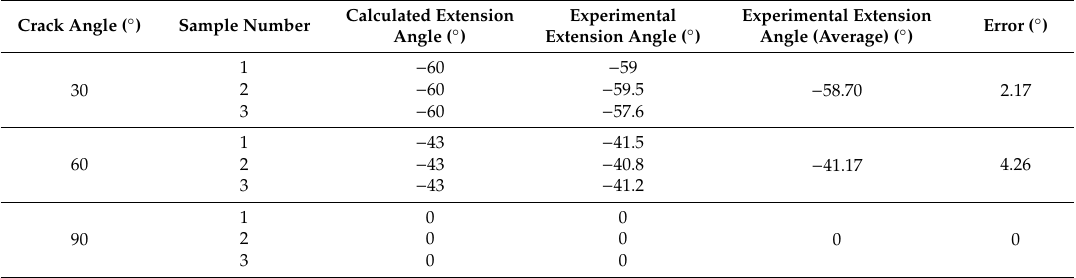
Table 3. Calculated extension angle and experimental extension angle.